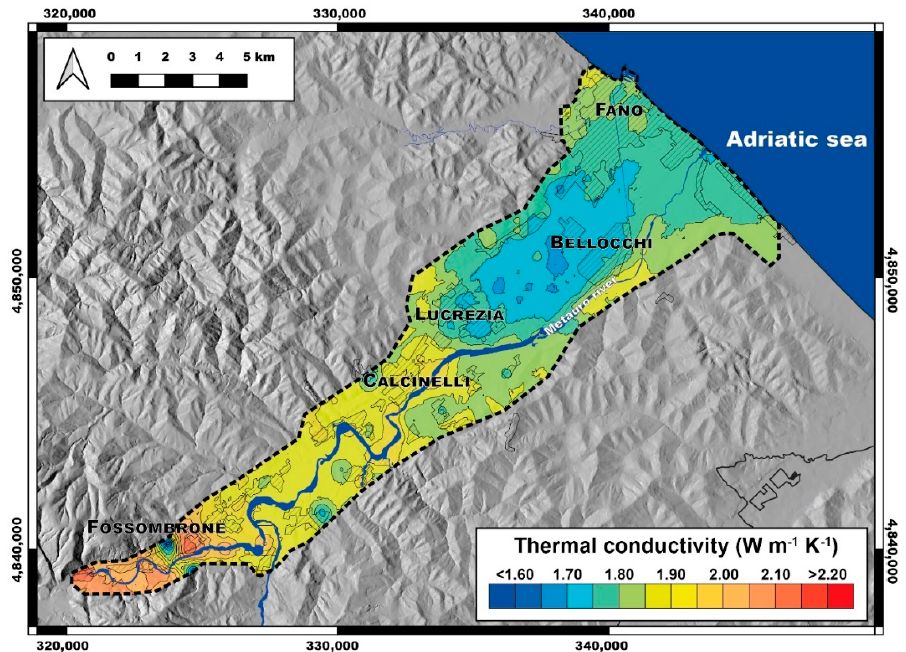
Figure 5. Map of the estimated thermal conductivity of the ground averaged over 100 m of depth from the surface.